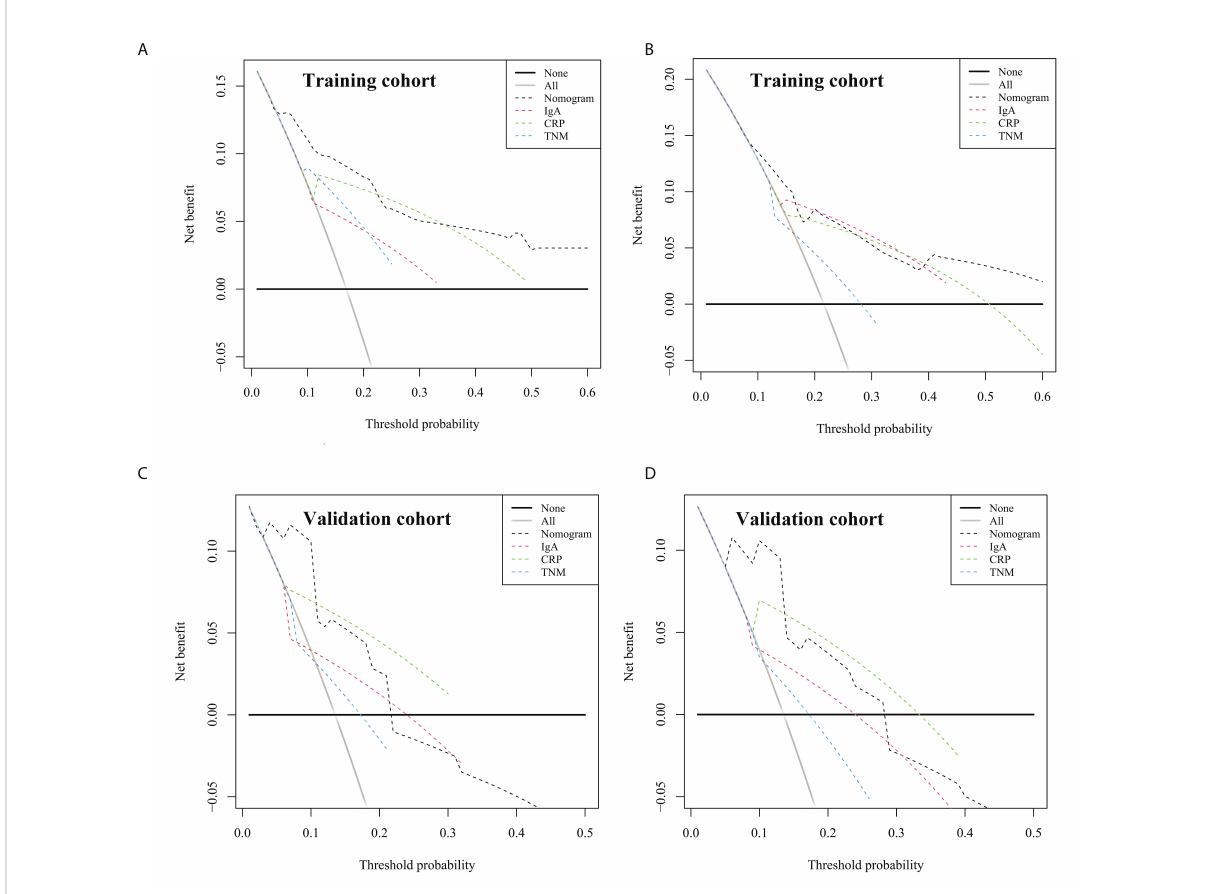
FIGURE 5 Decision curve analysis of the nomogram for overall survival (OS), compared with CRP, IgA, and clinical TNM stage. (A) The decision curve for 1- year OS in training cohort. (B) The decision curve for 3-year OS in training cohort. (C) The decision curve for 1-year OS in validation cohort. (D) The decision curve for 3-year OS in validation cohort. The straight black line represents the assumption that all patients die, and the horizontal line represents the assumption that no deaths happened. CRP, C-reactive protein; IgA, immune globin A.